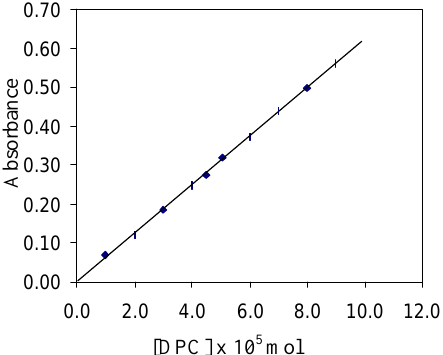
FigureFigure 11. Verification of Beer’s law for [DPC] at 415 nm in 0.02 mol dm -3